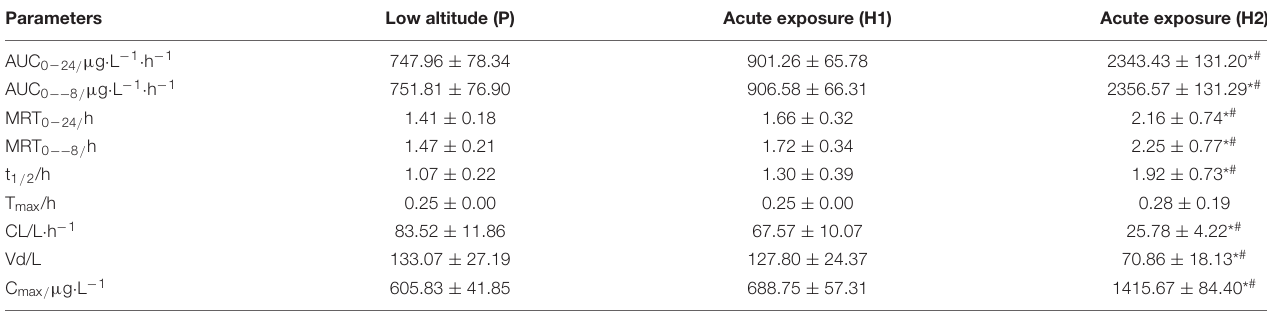
TABLE 2 | The main pharmacokinetic parameters of sildenafil in rats at low altitude and after acute exposure to high altitude (Mean ± SD, n = 8). Parameters